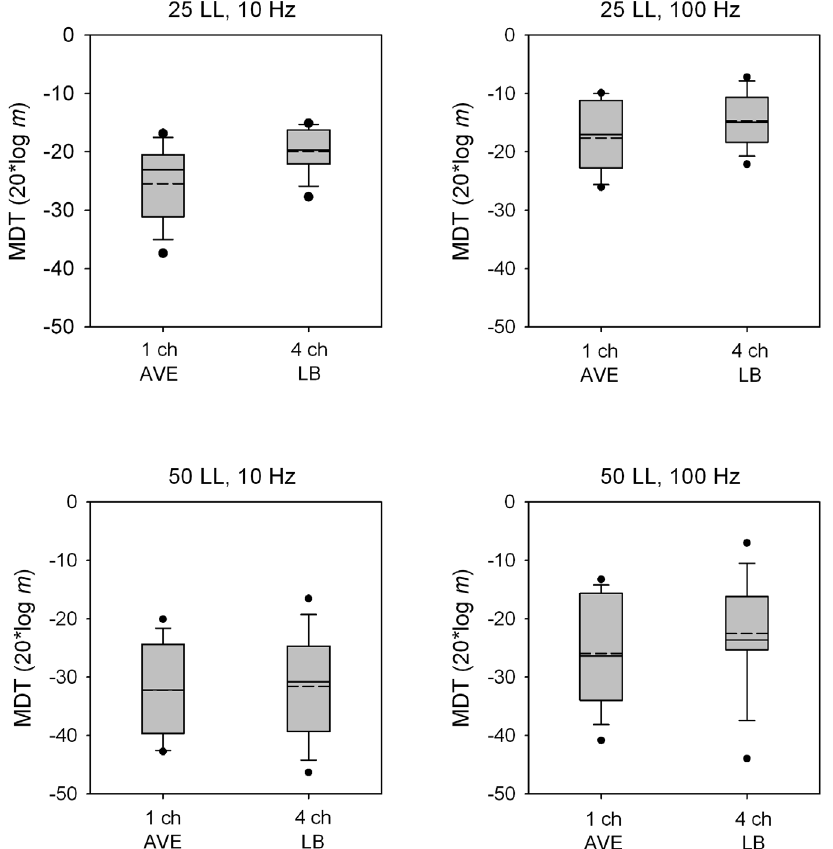
Figure 4. MDTs for equally loud single- and multi-channel stimuli. Box plots are shown for MDTs averaged across the best single channel or with the 4-channel loudness-balanced stimuli; note that all stimuli were equally loud. From left to right, the panels show data for the 25 LL/10 Hz, 25 LL/100 Hz, 50 LL/10 Hz, 50 LL/100 Hz conditions. In each box, the solid line shows the median, the dashed line shows the mean, the error bars show the 10 th and 90 th percentiles, and the black circles show outliers. single-channel stimuli shown in Figure 1. The gray bars show MDTs for the 4-channel stimuli without loudness-balancing, which were louder than the single-channel stimuli shown in Figure 1 and the 4-channel loudness-balanced stimuli. As with the single-channel MDTs, multichannel MDTs were generally better with the higher presentation level (50 LL) and the lower modulation frequency (10 Hz). In every case, 4-channel MDTs were poorer when current levels were reduced to match the loudness of the single-channel stimuli. A three-way RM ANOVA was performed on the data, with presentation level (25 LL, 50 LL), modulation frequency (10 Hz, 100 Hz), and loudness summation (4-channel with or without loudness-balancing) as factors. Results showed significant effects of presentation level [F(1,8) =18.13, p= 0.003], modulation frequency [F(1,8) =54.967, p , 0.001], and loudness summation [F(1,8) =97.287, p , 0.001]. Figure 4 shows boxplots for MDTs averaged across single channels or with the 4-channel loudness-balanced stimuli. Note that all stimuli were equally loud. Across all conditions, the average single-channel MDT was 3.13 dB better (lower) than with the 4-channel loudness-balanced stimuli; mean differences ranged from 0.70 dB for the 50 LL/10 Hz condition to 5.44 dB for the 25 LL/10 Hz condition. A Wilcoxon signed rank test showed that the average single-channel MDT was significantly better than that with the 4-channel loudness-balanced stimuli (p= 0.003). Similar- ly, a ranked sign test showed that MDTs with the best single